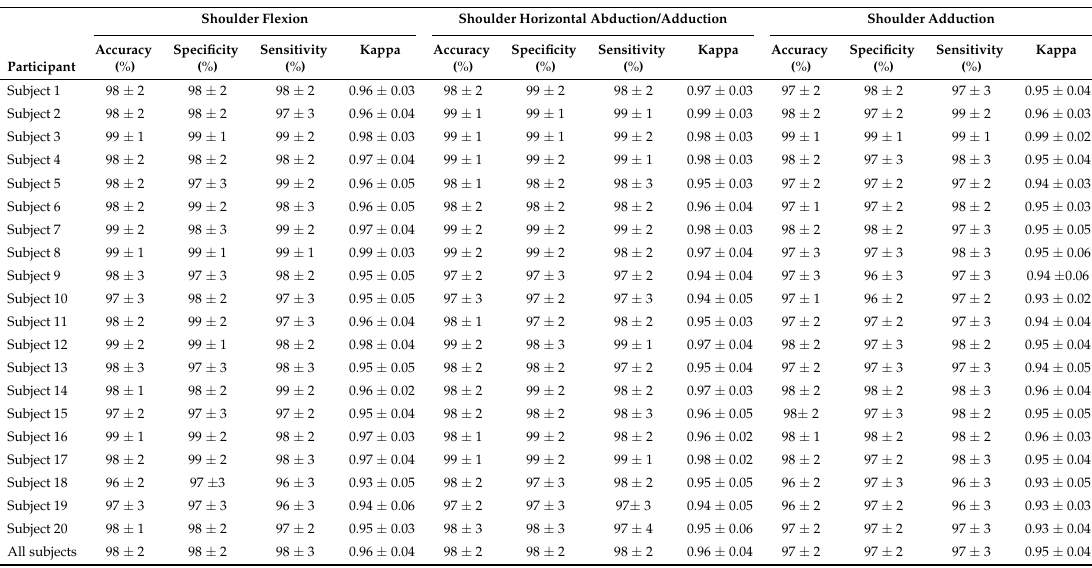
Table 4. The mean ± standard deviation accuracy, specificity, sensitivity, and kappa coefficient values obtained by the computerized assessment method for the twenty typically developing